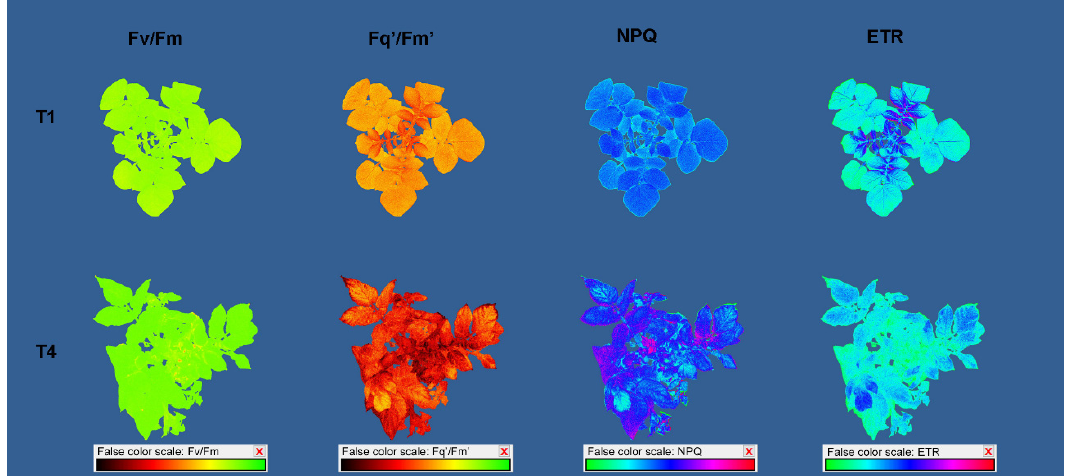
Figure 8. Potato pseudo-color images of the maximum quantum yield of PSII (F v /F m ), the effective quantum yield of PSII (F q ’/F m ’), non-photochemical quenching (NPQ), and electron transport rate (ETR) captured by CropReporter after ten days of growth in different temperature treatments: 20/15 °C (T1) and 35/30 °C (T4).